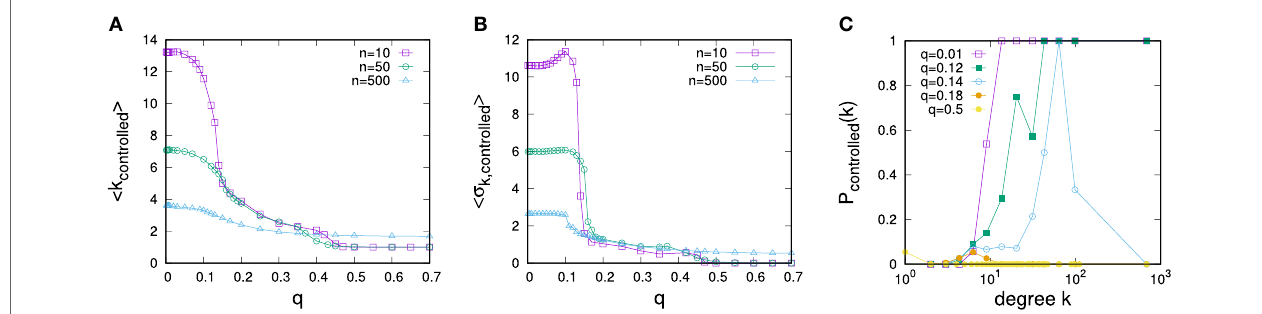
FIGURE 3 | Dependence of optimal strategies for opinion control on the predisposition parameter q : (A) average degree of controlled nodes, (B) degree variance of controlled nodes. (C) Dependence of the probability of a node to be controlled on degree for control optimized for different values of q for n = 10. The data are for networks of N = 1,000 nodes with (cid:11) = 3 and ⟨ k ⟩ = 3 and in (A,B) , each data point represents an average over 50 samples.